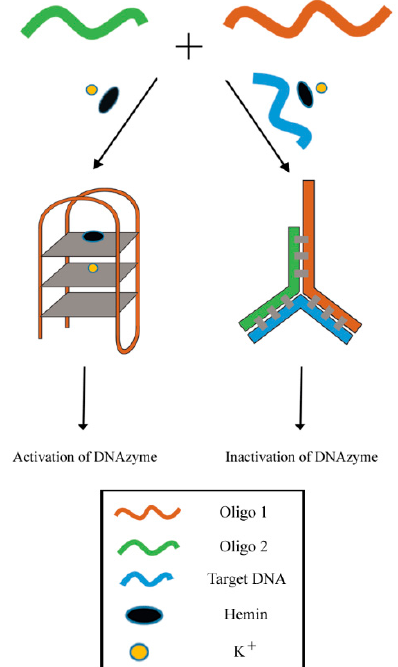
Figure 10. Schematic illustration for sequence-specific recognition of single-stranded DNA based upon Y-shaped DNA duplex and G4-hemin DNAzyme.